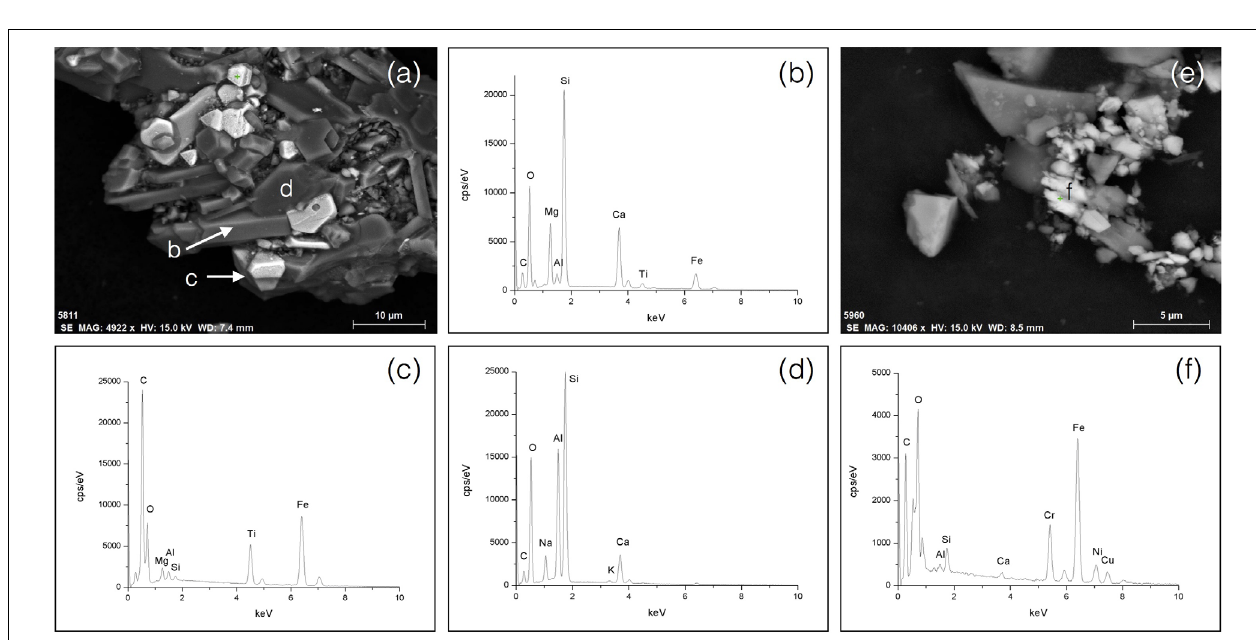
FIGURE 6 | Scanning electron microscopy micrographs and EDS spectra of (a) baryte, (b) Cu-Zn ore, and (c) Fe-Ti oxide grains in NyA sediments. The green crosses mark the spot analysis.